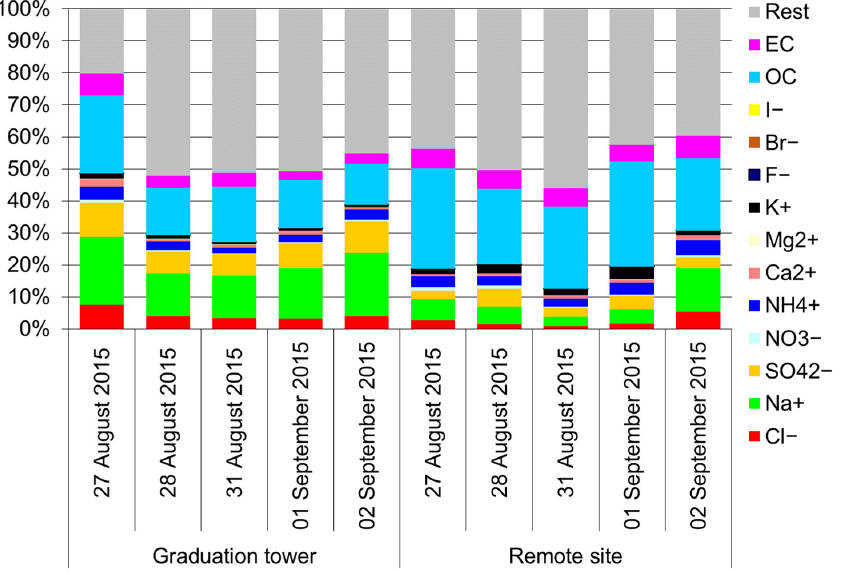
Figure 3. Mass percentage of various components in the PM 10 mass.